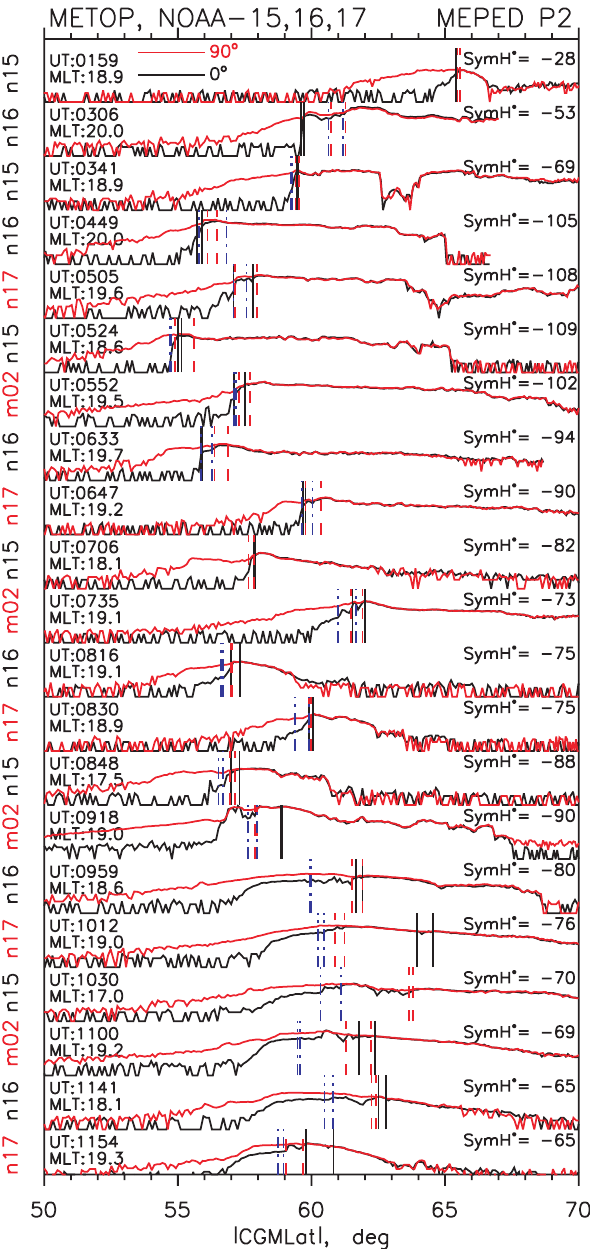
Fig. 8. Latitudinal profiles of proton number flux (MEPED P2, in log scale) in 17:00–20:00MLT sector. The panels are plotted chronologically. The MLT and UT on right and Sym-H ∗ on the left correspond to the time the satellite crossed of 60 ◦ CGMLat. Satel- lite name is shown at the vertical axis and the red (black) colors correspond to the auroral oval crossings in the Northern (Southern) Hemispheres. Vertical lines mark IB positions (P1 black; P2 red and P3 blue).